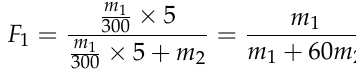
Table 3. Coding of simulation test factors.